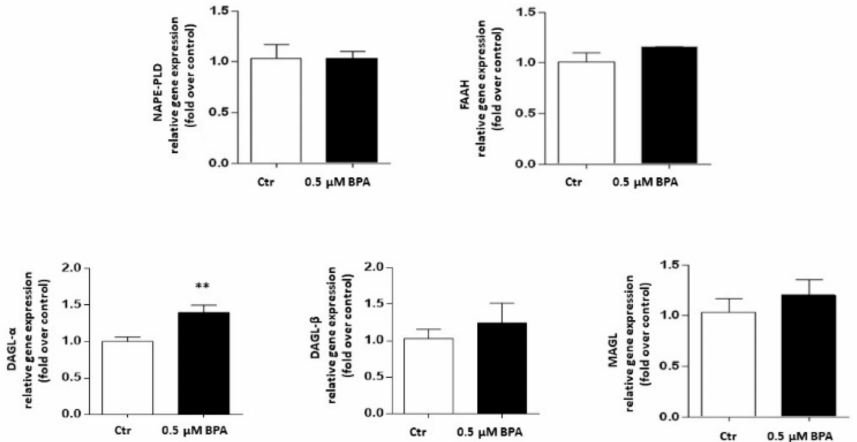
Figure 3. E ff ect of BPA (0.5 µ M for 48 h) on mRNA levels of eCB metabolic enzymes (NAPE-PLD, FAAH, DAGL- α , DAGL- β and MAGL) in exposed Sertoli cells, compared to vehicle-treated controls (Ctr). Gene expression was reported as 2 − ∆∆ Ct values calculated by ∆∆ Ct method vs. Ctr, posed equal to 1.0. Expression levels of each gene were normalized to β -actin, and data were reported as means ± SEM of 5 independent experiments. ** p < 0.05 vs.